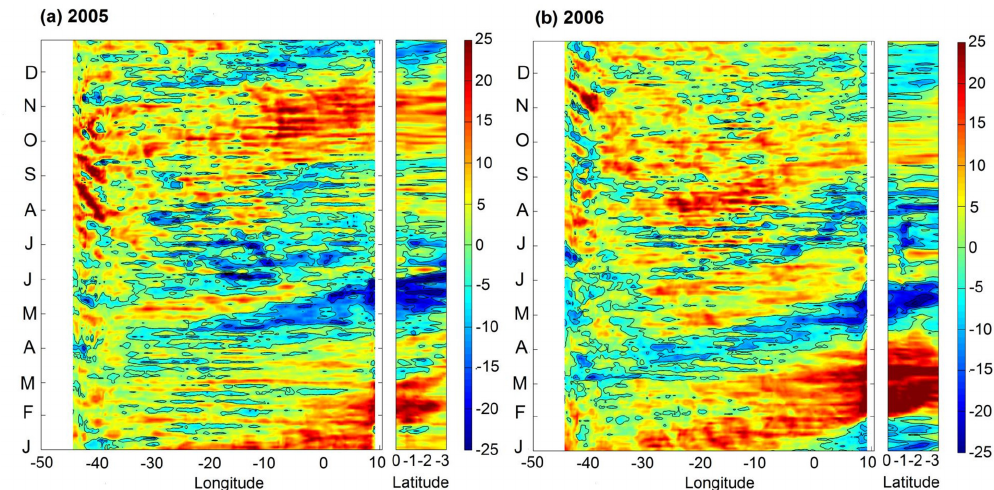
Figure 5. Time evolution of the intraseasonal anomaly of 20 ◦ C isotherm depth (m) along the Equator (between 54 ◦ W and 12 ◦ E) and along 9 ◦ E (between the Equator and 3 ◦ S) for 2005 (a) and 2006 (b) . Negative values indicate a 20 ◦ C isotherm depth closer to the surface. For details about calculations of the anomalies, see Sect. 2.